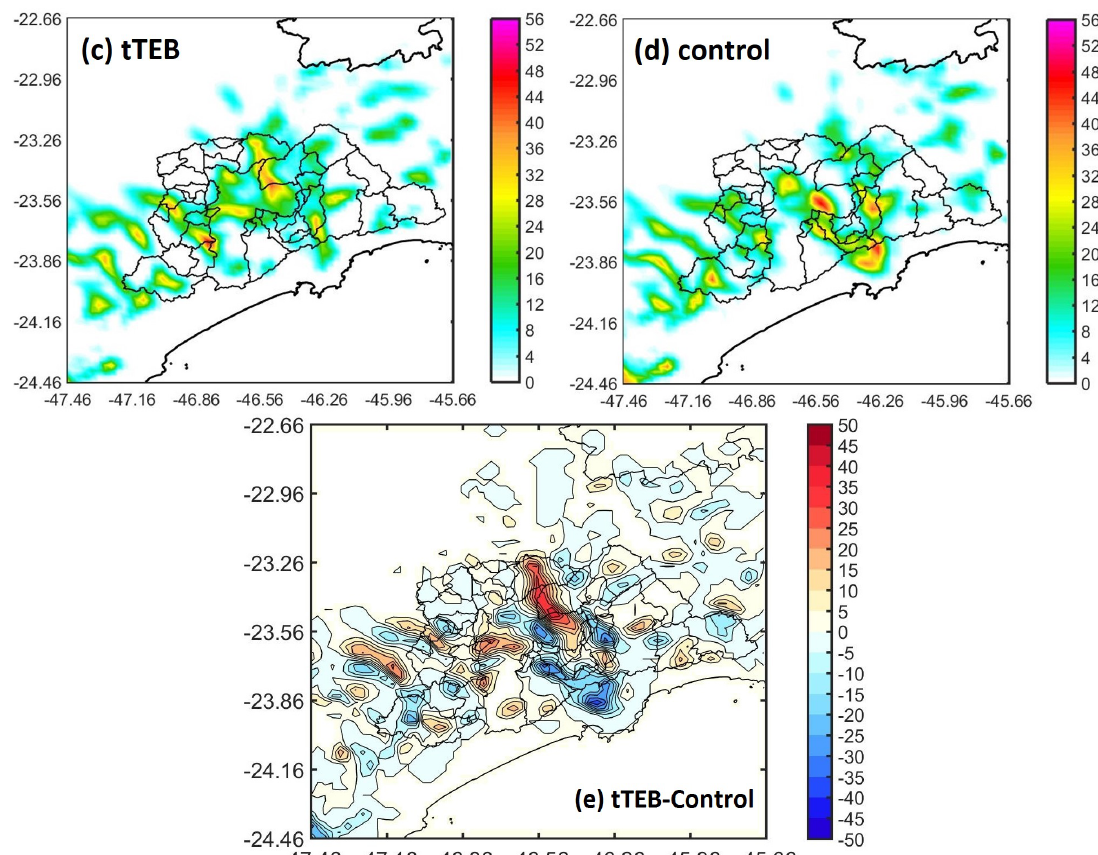
Figure 8. Spatial distribution of accumulated precipitation rate (mm h − 1 ) between 17 UTC (14 LT) and 21 UTC (18 LT) estimated by ( a ) CMORPH: Climate Prediction Center (CPC) morphing technique (resolution: 0.25 ◦ ), ( b ) GPM: global precipitation measurement (resolution: 0.1 ◦ ), ( c ) tTEB experiment (resolution: 3 km), ( d ) Control experiment (resolution: 3 km) and ( e ) differences between tTEB and